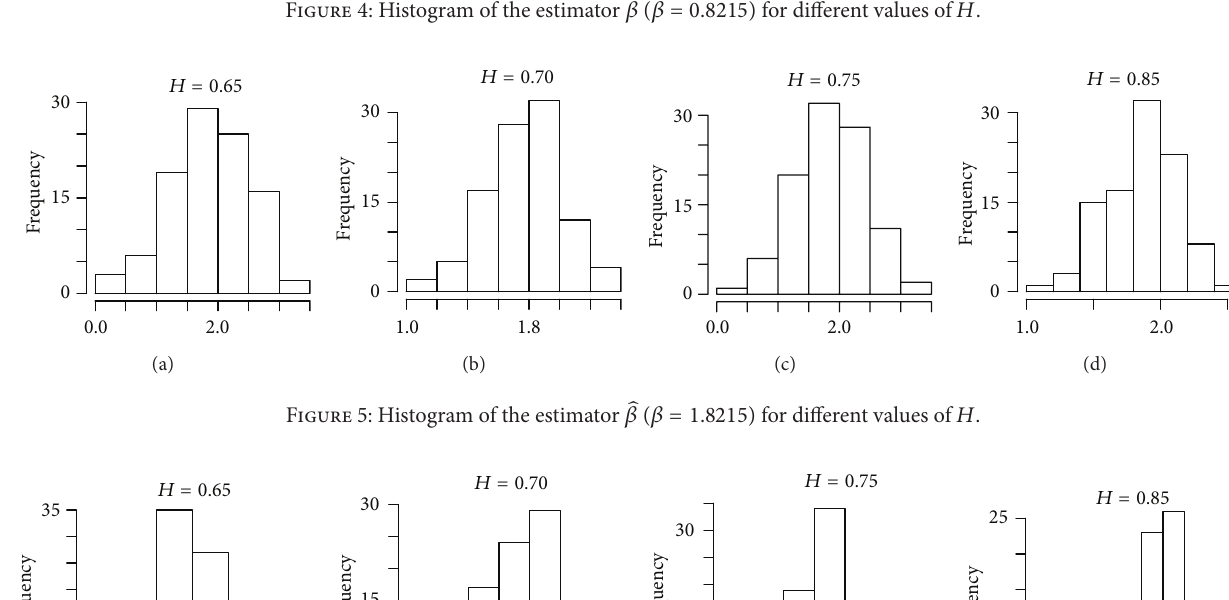
Figure 5: Histogram of the estimator